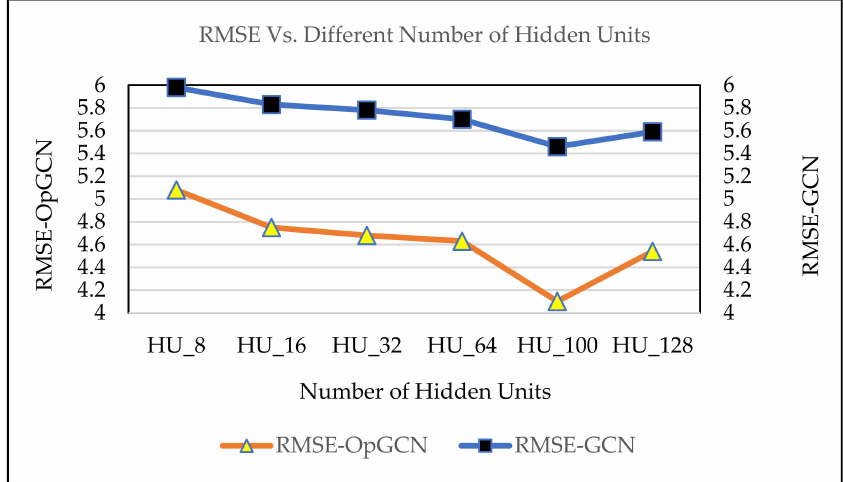
Figure 7. RMSE (Root Mean Square Error) vs. Number of hidden units (HU). Comparing RMSE with varying number of hidden units used in the model. GCN: graph convolutional neural network; OpGCN: optimized GCN.